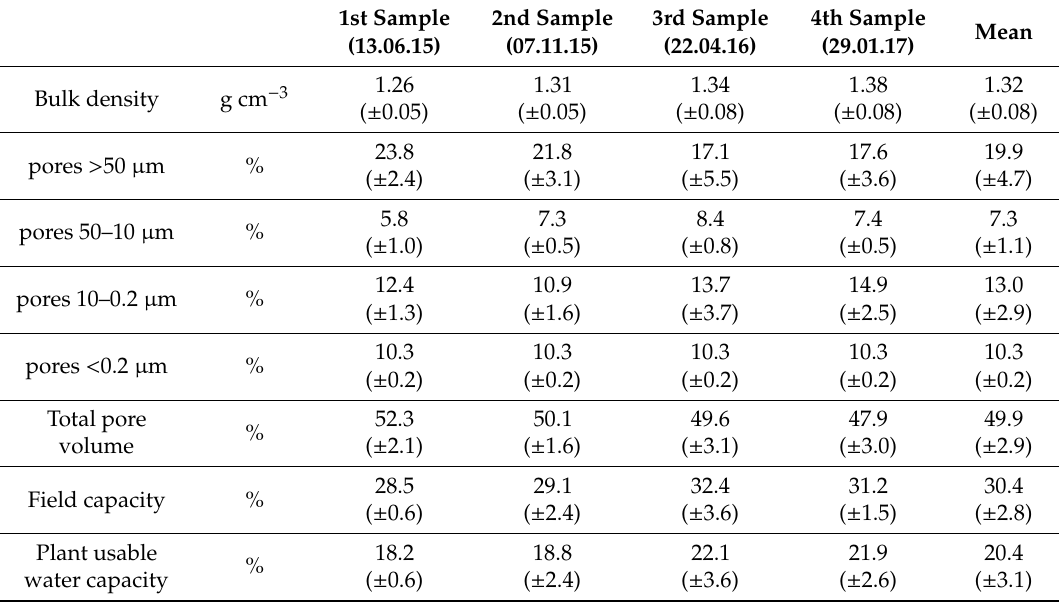
Table 2. Dynamics of pore size distribution and bulk density (mean values ± standard deviation, n = 18) in the course of the